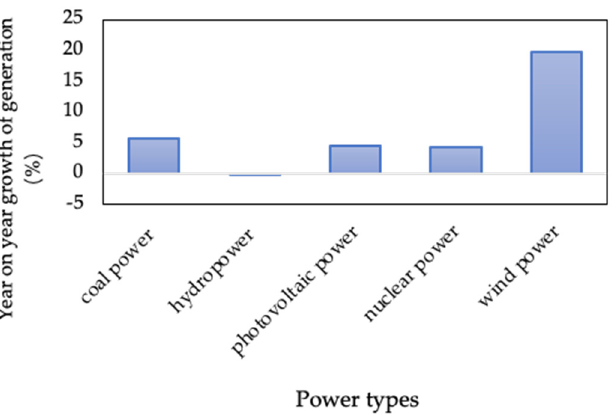
Figure 3. The growth rate of each power generation type in the first three quarters of 2021.